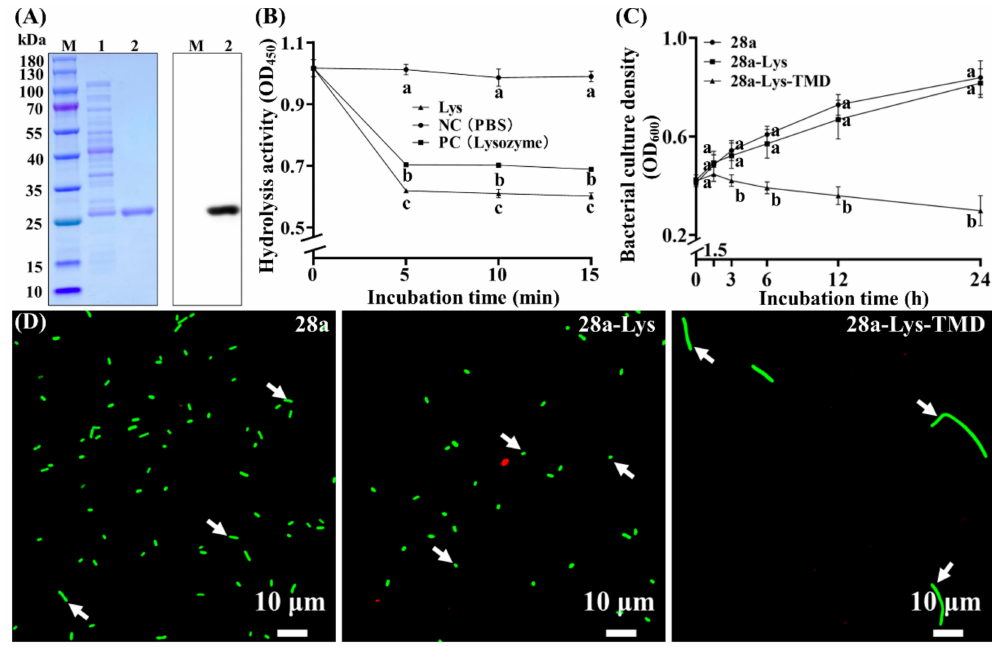
Figure 9. Antibacterial activity of X2-Lys with the help of TMD. ( A ) SDS-PAGE and Western Blot- ting of the purified X2-Lys. Lane M: maker; Lane 1: unpurified X2-Lys; Lane2: purified X2-Lys. ( B ) Hydrolytic activity of peptidoglycan by purified X2-Lys. NC: negative control; PC: positive control. Mean ± SD are shown ( n = 3). Different lowercase letters represent significant difference ( p < 0.05) in hydrolytic activity among the three groups of X2-Lys, PBS (NC) and lysozyme (PC) at the same time point. ( C ) Bacterial growth after 0, 1.5, 3, 6, 12 and 24 h of IPTG induction ( n = 9). Different lowercase letters represent significant difference ( p < 0.05) in bacterial culture density among the three groups of 28a, 28a-Lys and 28a-Lys-TMD at the same time point. ( D ) Fluorescence microscopic observation after induction of 12 h. 28a, empty control plasmid; 28a-Lys, 28a plasmid carrying X2-Lys; 28a-Lys-TMD, 28a plasmid carrying X2-Lys and a transmembrane domain. Bacteria with different morphology were marked with white